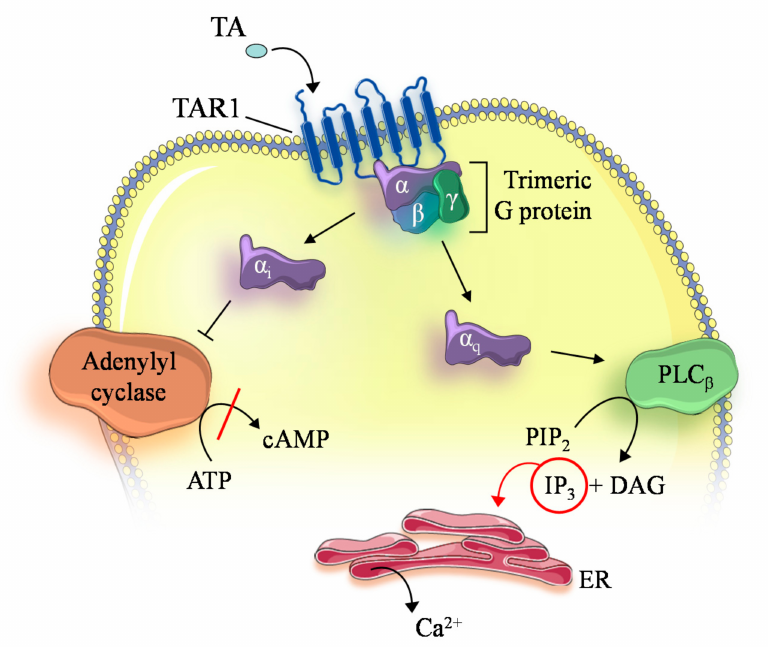
Figure 1. Intracellular signaling pathways trigged by TAR1 activation. ATP (Adenosine triphosphate), cAMP (Cyclic adenosine monophosphate), PLC β (phospholipase C β ), PIP2 (Phosphatidylinositol 4,5-bisphosphate), IP3 (Inositol trisphosphate), DAG (Diacylglycerol), ER (Endoplasmatic reticulum).